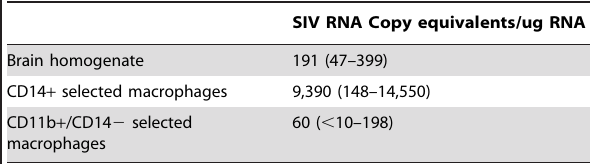
Table 1. SIV Replication in Brain 4 Days